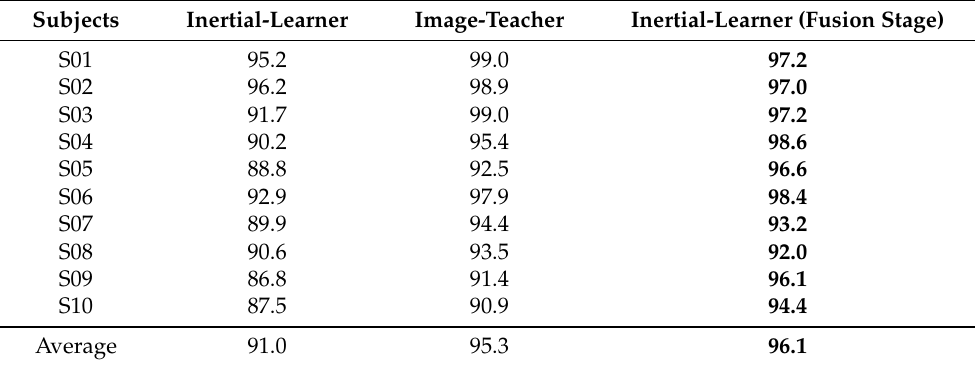
Table 11. Comparison of the average classification accuracy (expressed in percentage) of the perfor- mance achieved when the Inertial-Learner model is trained over TL-FmRADLs against the baseline performance of the image-teacher model.